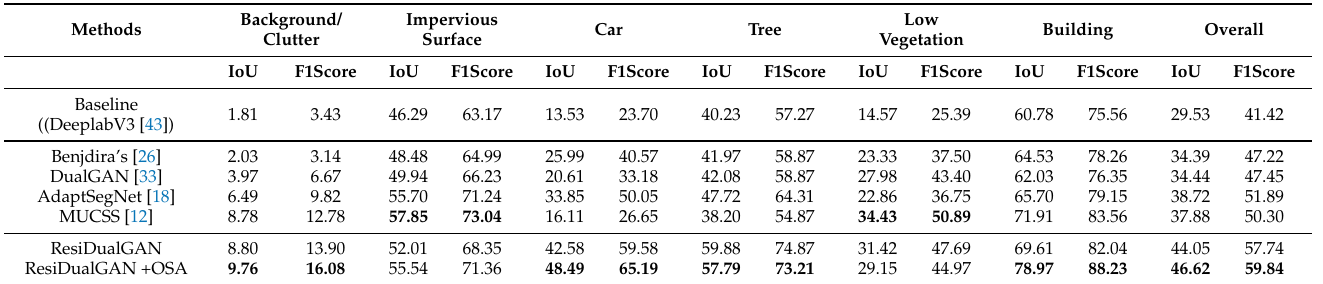
Table 2. The quantitative results of the cross-domain semantic segmentation from PotsdamRGB to